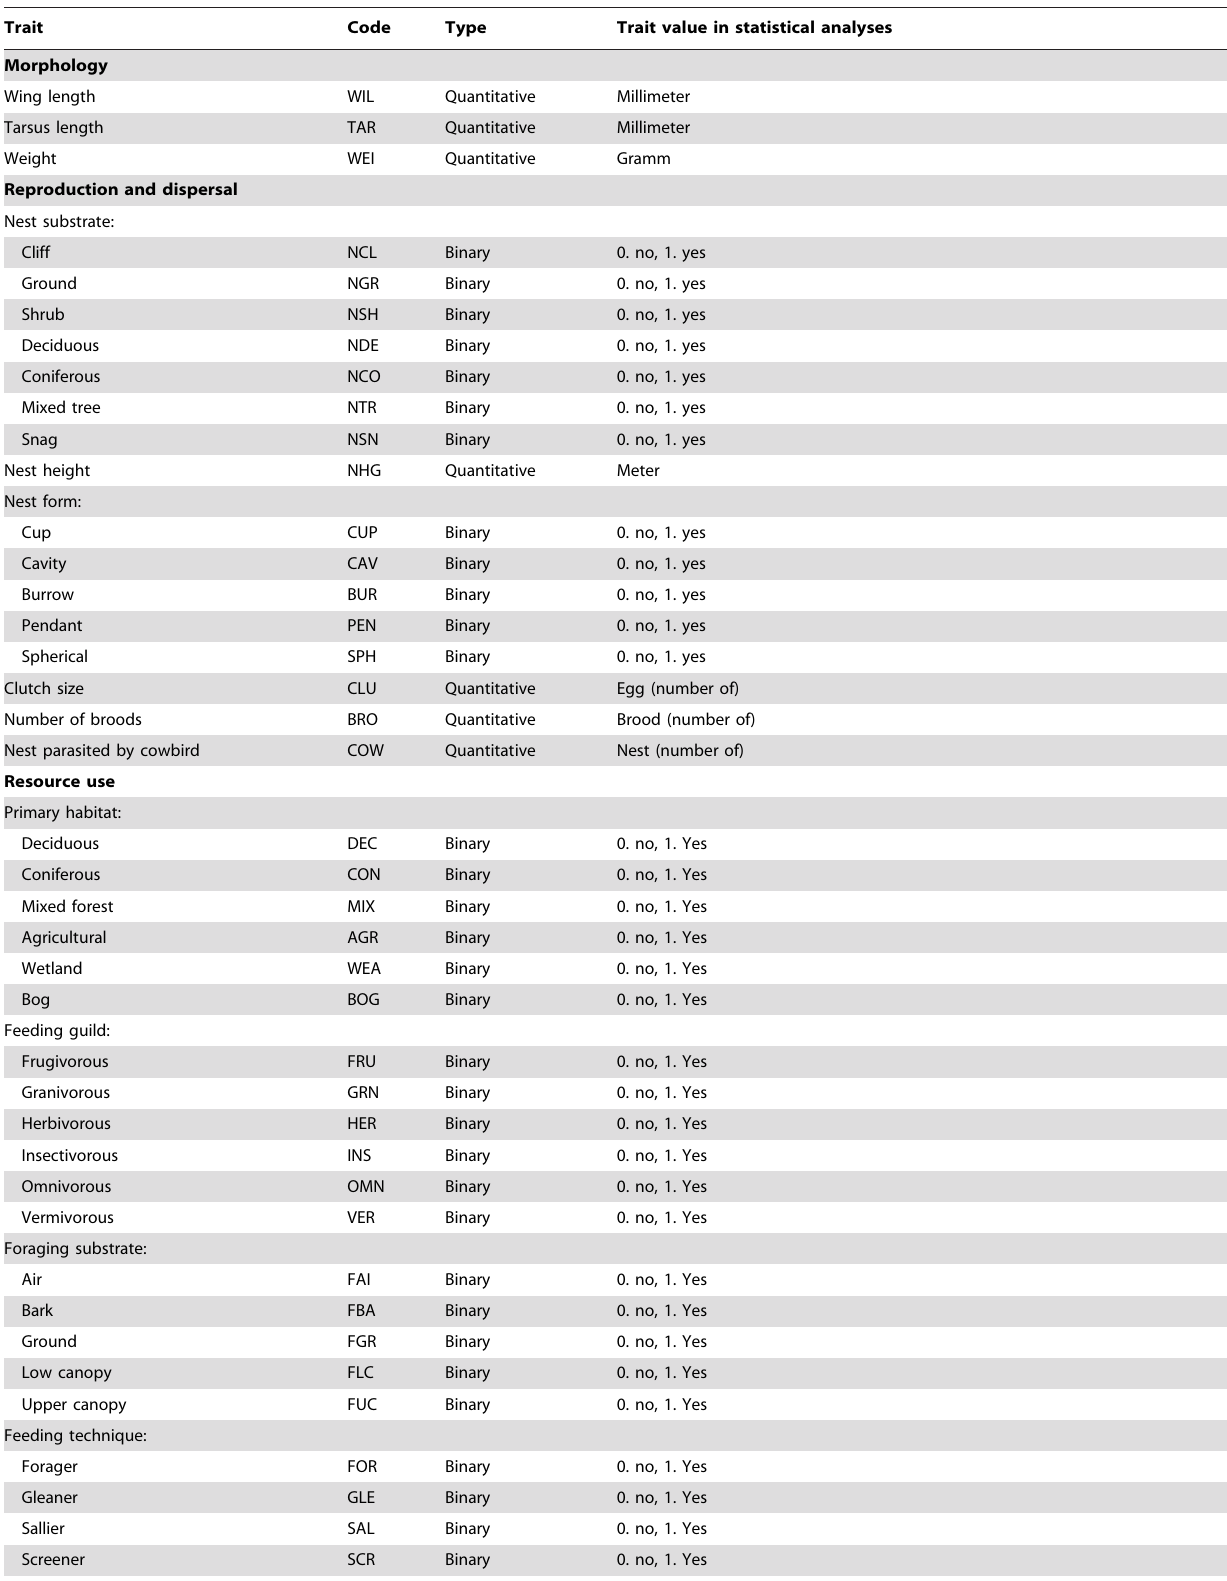
Table 3. Description and codes of songbird functional traits used in this study.